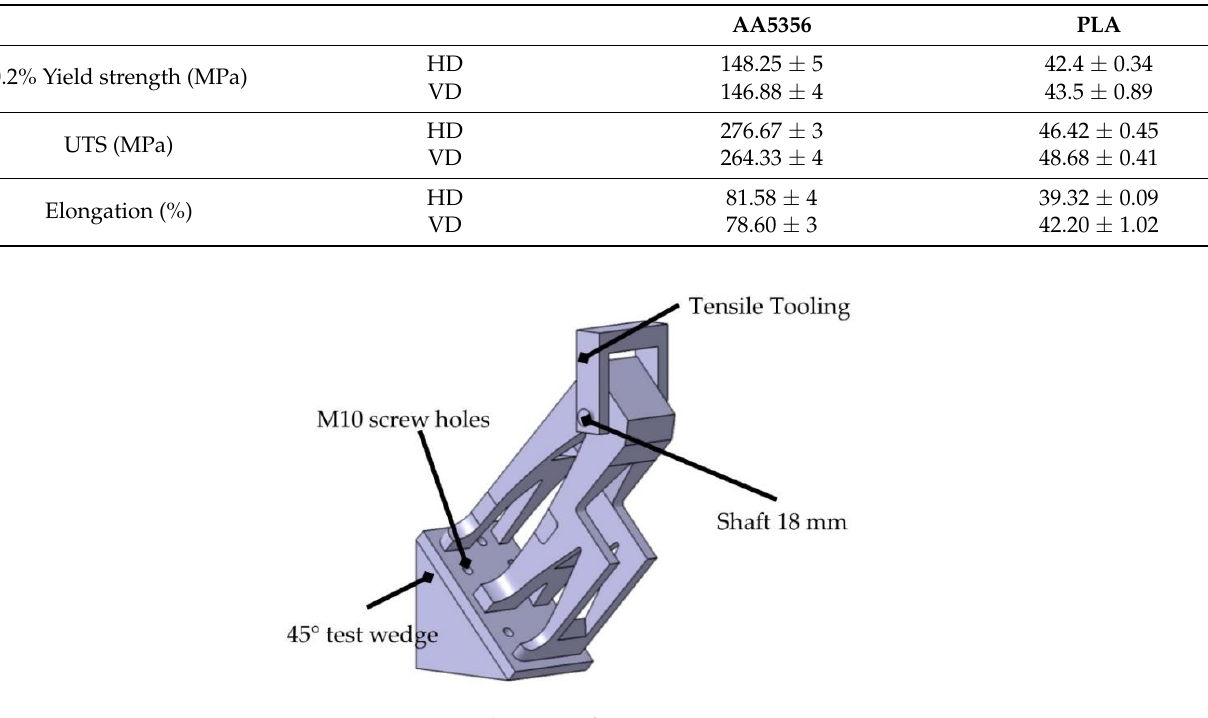
Figure 5. Turret tensile test configuration: 45° test case .